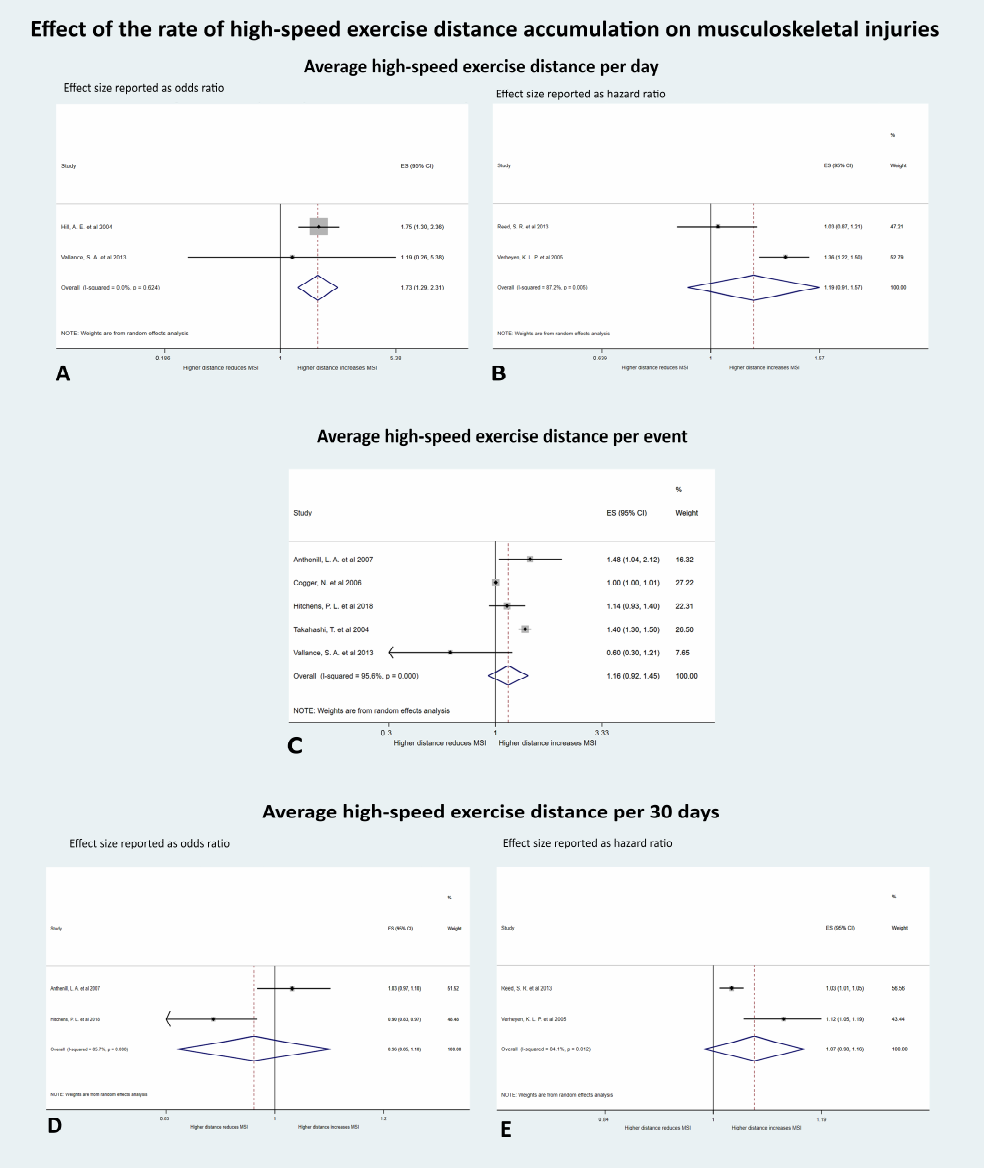
Figure 5. Forest plots of the effect of measures of the rate of high-speed exercise (HSE) distance accumulation on musculoskeletal injuries (MSI) in Thoroughbred racehorses ( A ). Average HSE distance per day with effect size (ES) reported as odds per increase of 1 furlong (200 m) of HSE history ( B ). Average HSE distance per day with ES reported as hazard per increase of 1 furlong of HSE history ( C ). Average HSE distance per event with ES reported as odds per increase of 1 furlong of HSE history ( D ) Average HSE distance per 30 days with ES reported as odds per increase of 1 furlong of HSE history ( E ). Average HSE distance per 30 days with ES reported as hazard per increase of 1 furlong of HSE history. A further two studies from the UK explored the e ff ect of the average HSE distance per 30 days on MSI using time to event data and reporting hazard ratios as the e ff ect size [28,61]. The injury types evaluated were metacarpophalangeal / metatarsophalangeal joint disease (n = 1) and dorsal metacarpal disease (n = 1). With every increase of 1 furlong in the average HSE distance per 30 days, the HR of MSI increased by 7%, although this was not significant (HR 1.07 (95% CI 0.99 to 1.16; p = 0.11)). The tau-squared was 0.003, Cochrane’s Q was 6.28 ( p = 0.01) and I 2 was 84%, indicating high and significant